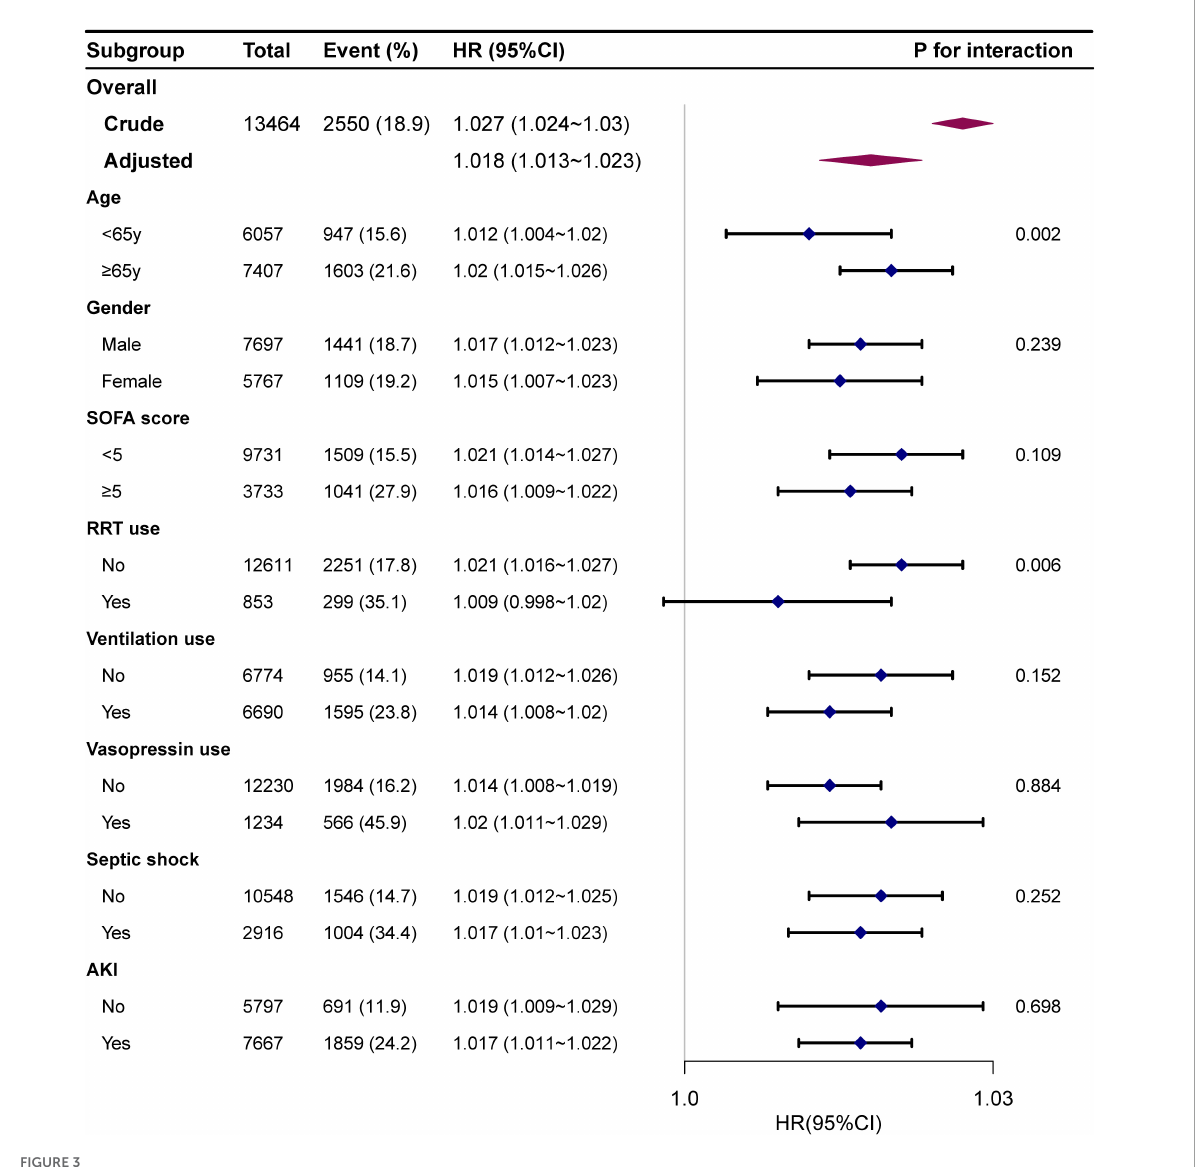
than BUN or serum albumin in assessing disease severity